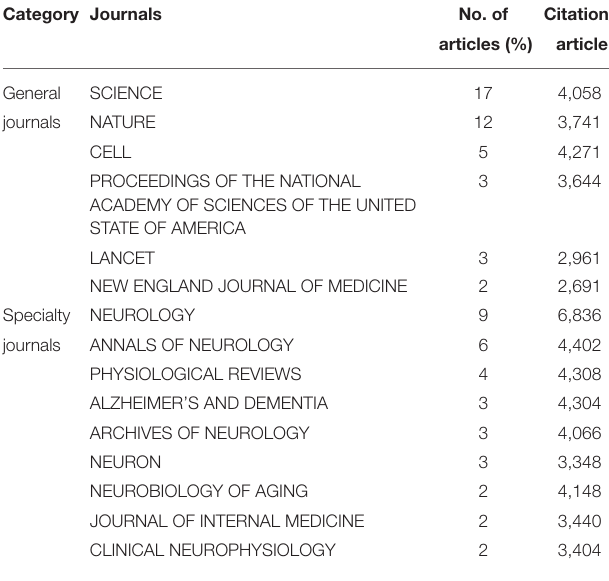
TABLE 2 | Journals with multiple articles in the most-cited